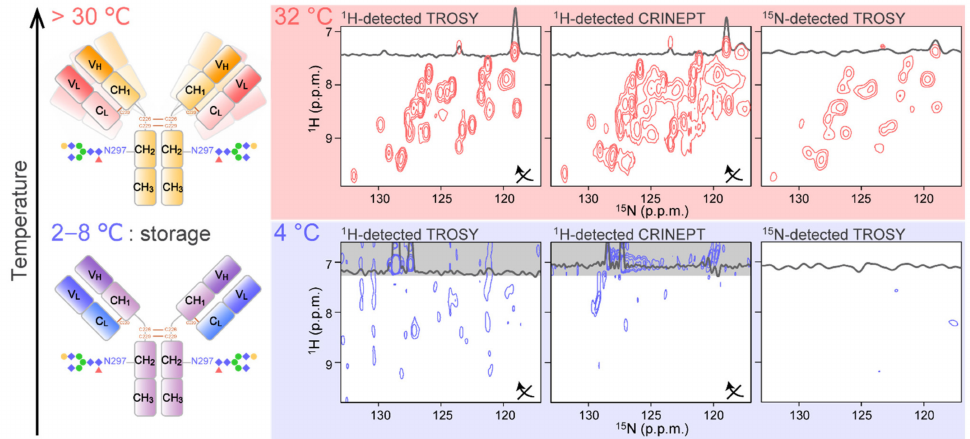
Figure 2. Application of conventional 2D 1 H- 15 N correlation experiments to mAb. The spectra were recorded at (top) 32 ◦ C and (bottom) 4 ◦ C for an intact [ 15 N-Ala] IgG. For each condition, the 1 H- detected TROSY (left), 1 H-detected CRINEPT (middle), and the 15 N-detected TROSY (right) were recorded. For 1 H-detected spectra, the 1 H and 15 N axes of the spectra are transposed as indicated by arrows. The figure is reproduced from